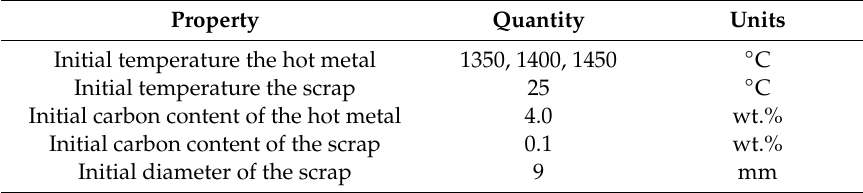
Table 4. Investigation parameters of the mathematical